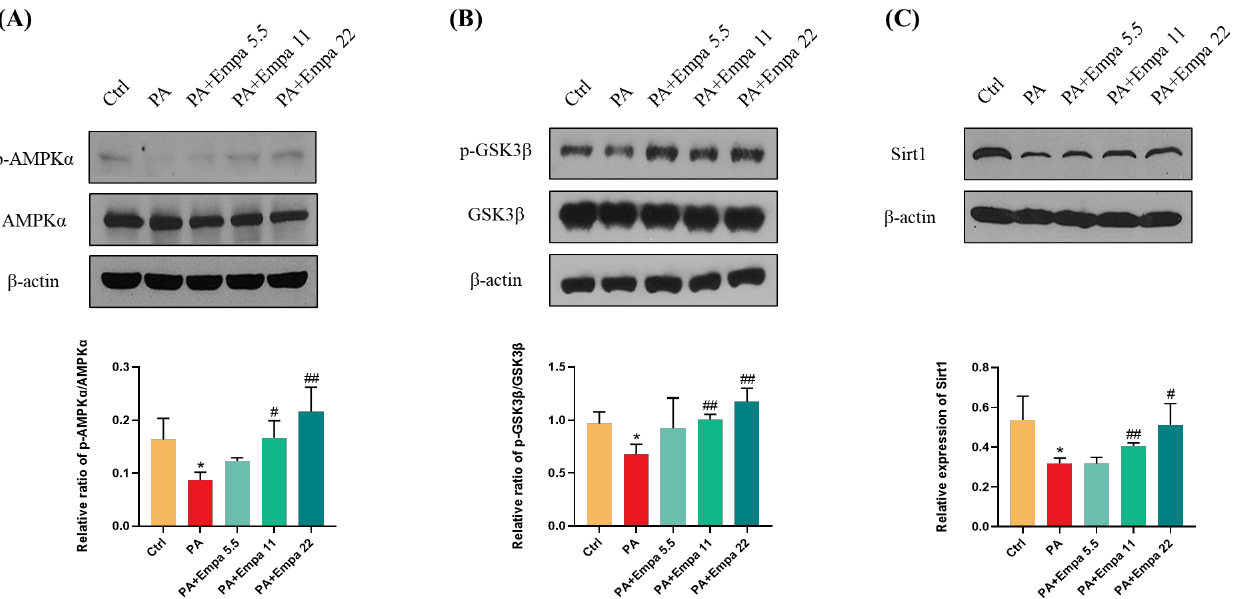
Figure 5. Empa promoted AMPK α and GSK3 β phosphorylation and upregulated Sirt1 levels in LO2 cells treated with PA. ( A ) Empa improved intracellular p -AMPK α protein level impaired by PA (0.5 mM) in LO2 cells. ( B ) Empa improved intracellular p -GSK3 β protein level impaired by PA in LO2 cells. ( C ) Empa increased Sirt1 protein level inhibited by PA in LO2 cells. All data are expressed as mean ± SD ( n = 3). * p < 0.05 versus Ctrl. # p < 0.05, and ## p < 0.01 versus PA. Ctrl, PA-untreated normal control group; PA, PA-treated control group; PA + Empa 5.5-22, PA-treated and Empa-treated (at final concentrations of 5.5-22 μ M) groups.